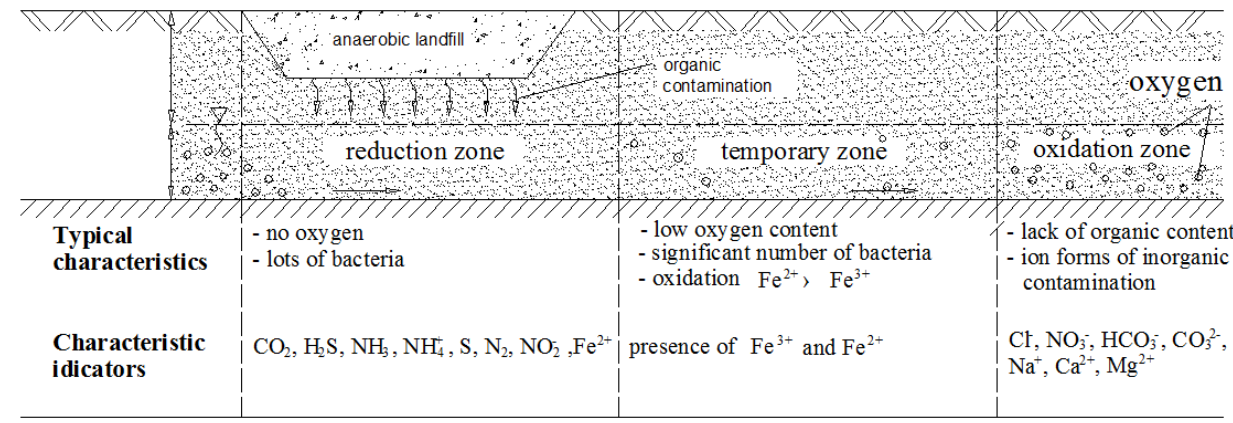
Figure 1. Pattern of contamination zones migration within landfill’s